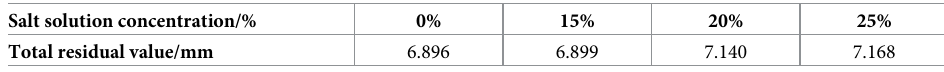
Table 11. Total residual deformation of reinforced concrete columns with different salt solution concentrations under axial